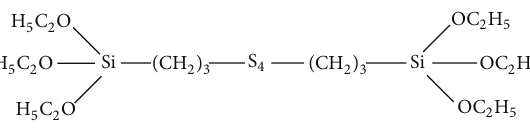
Figure 5: Chemical structure of silane coupling agent